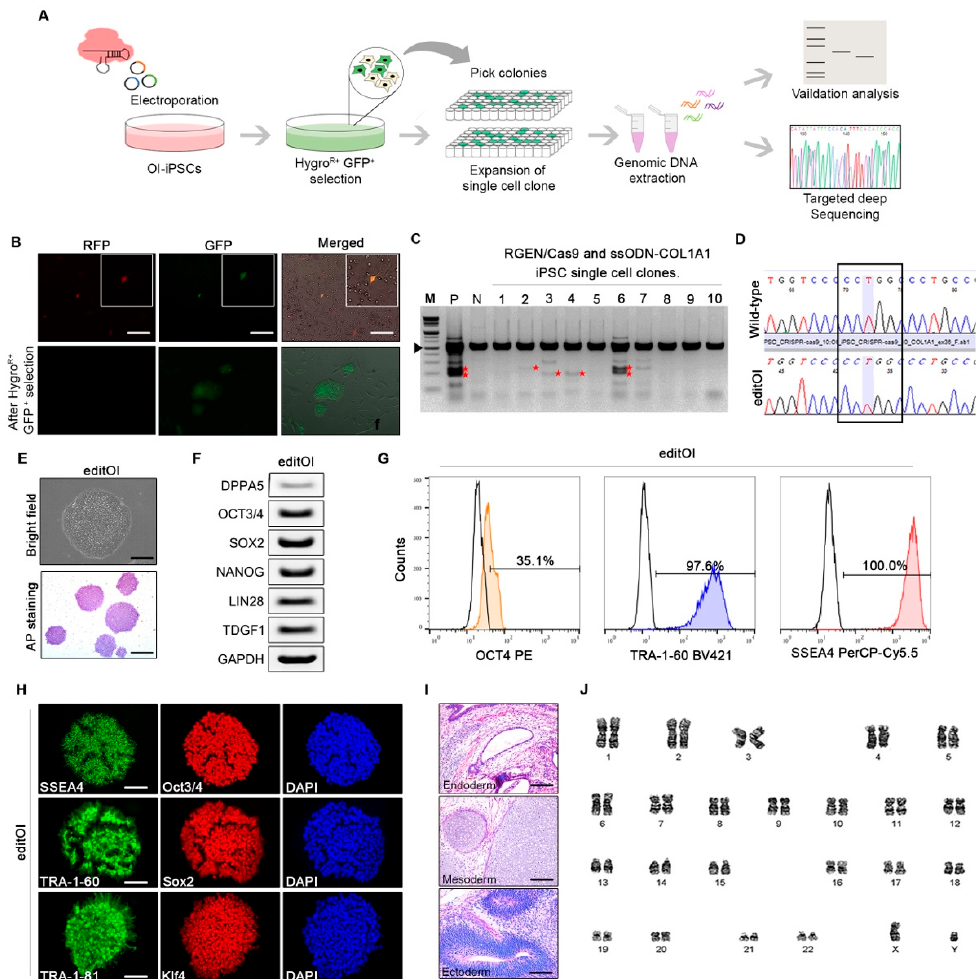
Figure 3. CRISPR/Cas9-mediated editing of the COL1A1 gene in OI-iPSCs. ( A ) Schematic representation for CRISPR/Cas9-mediated editing of the COL1A1 gene in OI-iPSCs. ( B ) Fluorescence image of transfected colony. Stable GFP-positive cells were obtained by selection with hygromycin B (scale bars: 100 µ m). ( C ) T7E1 assay for insertions and deletions. ( D ) Direct sequencing analysis. We generated a COL1A1 -corrected iPSC clones of OI patient (editOI-iPSCs). ( E ) Microscopic morphology and AP staining of the COL1A1 -corrected iPSC clones (editOI-iPSCs) (upper panel; scale bars: 100 µ m, lower panel; scale bars: 200 µ m). ( F ) Pluripotent marker PCR results and ( G ) flow cytometry analysis of cells expressing OCT4, TRA-1-60 , and SSEA4. ( H ) Immunofluorescence image of editOI-iPSCs analyzed for pluripotency markers (scale bars: 100 µ m). ( I ) editOI-iPSC teratoma histology (scale bars: 100 µ m). ( J ) Morphology and karyotype of editOI-iPSCs.